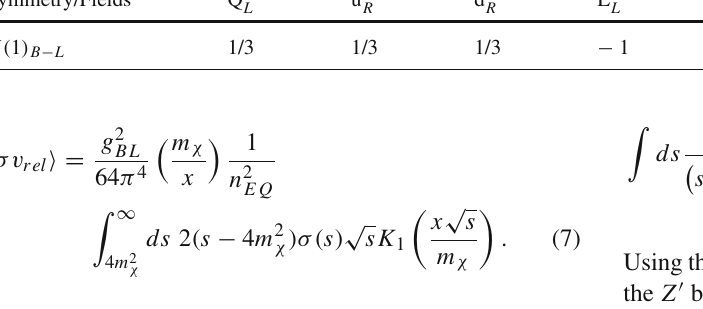
Table 1 Particles content and U ( 1 ) B − L charges of the model, where i = 1 , 2 , 3 represent the three generation indices. Here, besides three-right handed neutrinos, a scalar singlet φ and a vector-like Dirac DM particle χ are also present